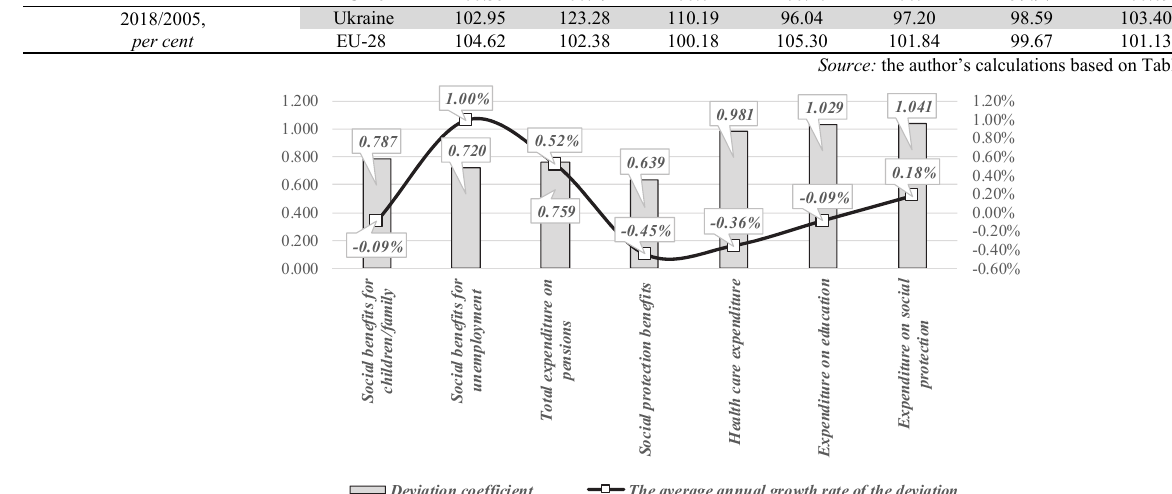
Fig. 1. The average annual rate of Ukraine’s deviations of indicators of development of the social sphere from the EU-28 for